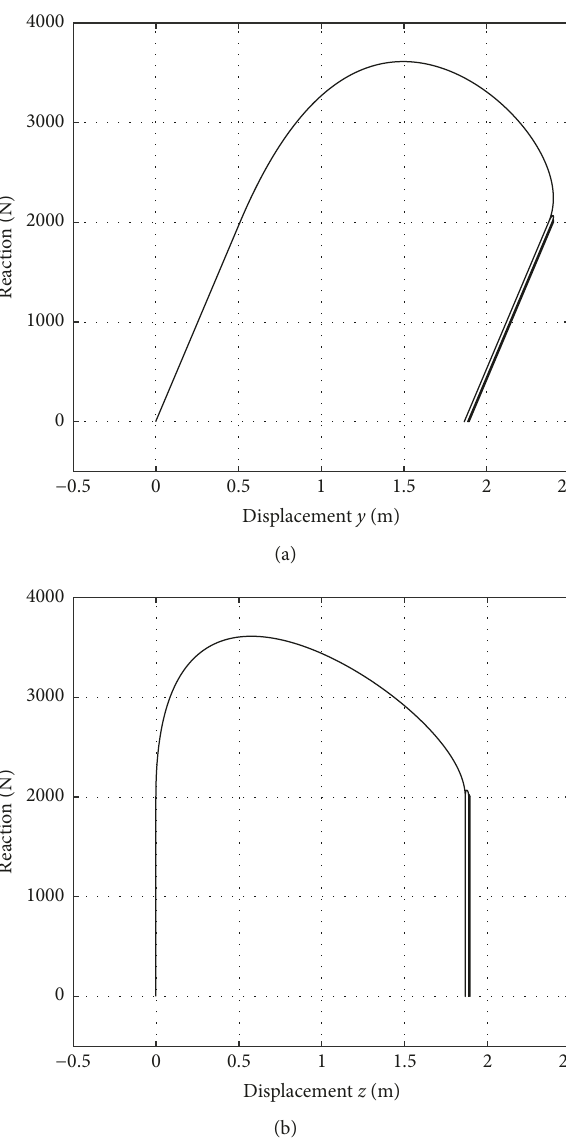
Figure 14: Hysteretic loops in elastic-viscoplastic system: relation- ships (𝑅,𝑦) (a) and (𝑅,𝑧)